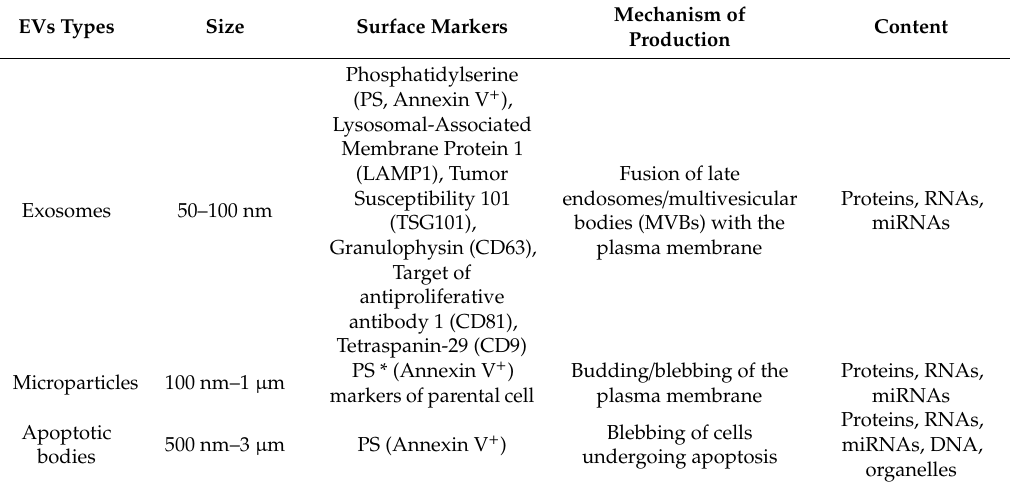
Table 1. General characteristics of extracellular vesicles